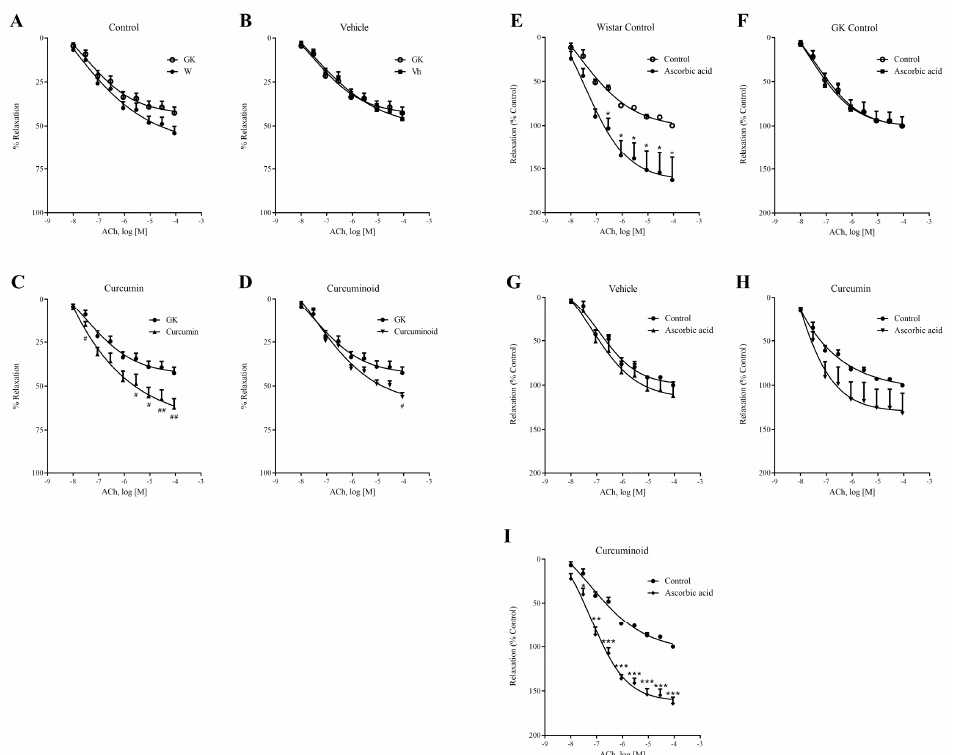
Figure 3. Effects of curcumin or curcuminoid treatment on relaxation response of the isolated aorta to acetylcholine (ACh) before ( A – D ) and after preincubation with ascorbic acid ( E – I ) from Wistar rats ( A , E ), GK control rats ( F ), GK Vehicle rats ( B , G ) and GK rats administered with curcumin ( C , H )